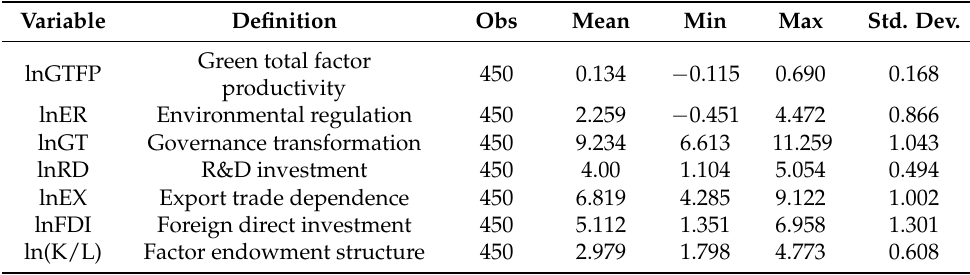
Table 1. Descriptive statistics of the variables from 2003 to 2017.